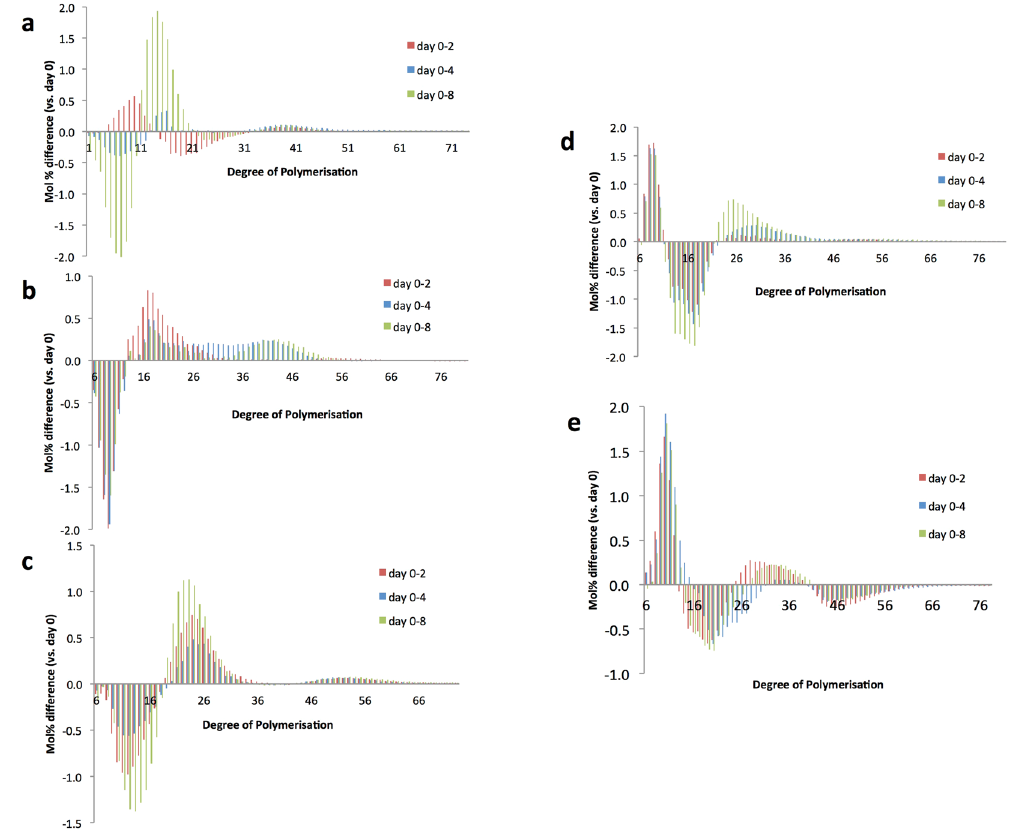
Figure 4. Change in amylopection chain length distribution during germination. Mol% difference of debranched amylopectin chains at 3 different germination time points (days 2, 4 and 8) compared with ungerminated seeds (day 0) for ( a ) IR65, ( b ) IR24, ( c ) IR64, ( d ) IR36, and ( e ) IR36AE. Positive values indicate a decrease while negative values indicate an increase in the amount of chains compared to day